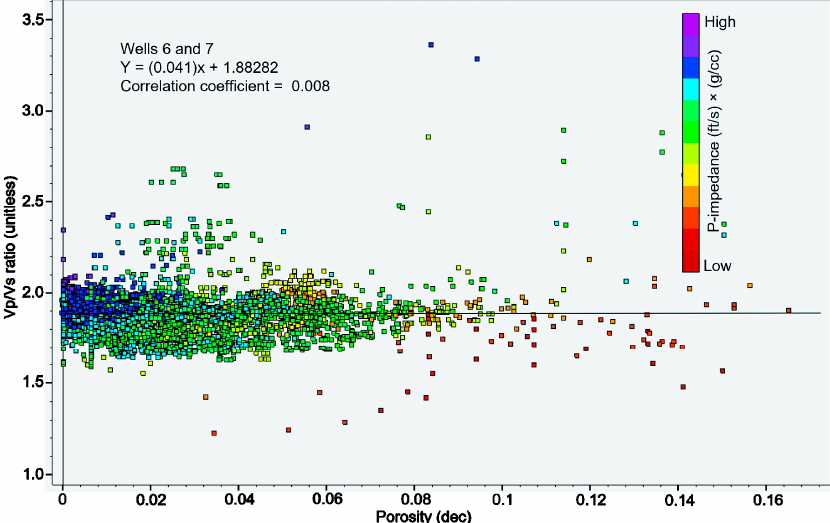
Figure 18. Cross plot of porosity versus Vp/Vs ratio color coded with impedance for wells 6 and 7. Note: slope of best-fit line almost zero at 0.04, suggesting Vp/Vs ratio almost constant at ~1.88. Overall, Vp/Vs ratio increases with increasing porosity. Refer to text for